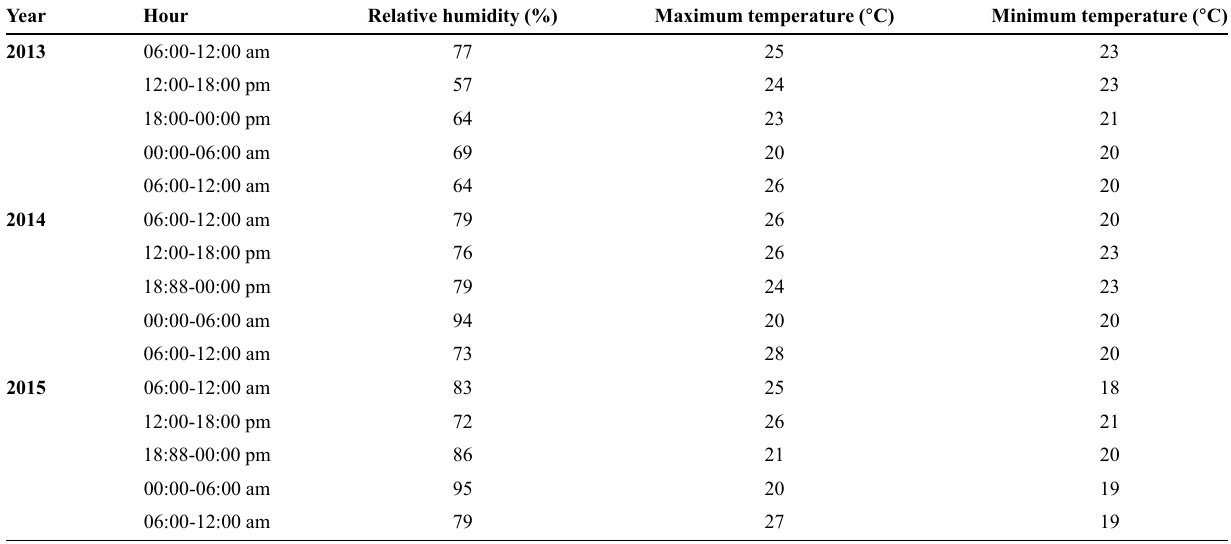
Table 1 - Weather characteristics of the three editions of Ultramarathon Rio 24 h *